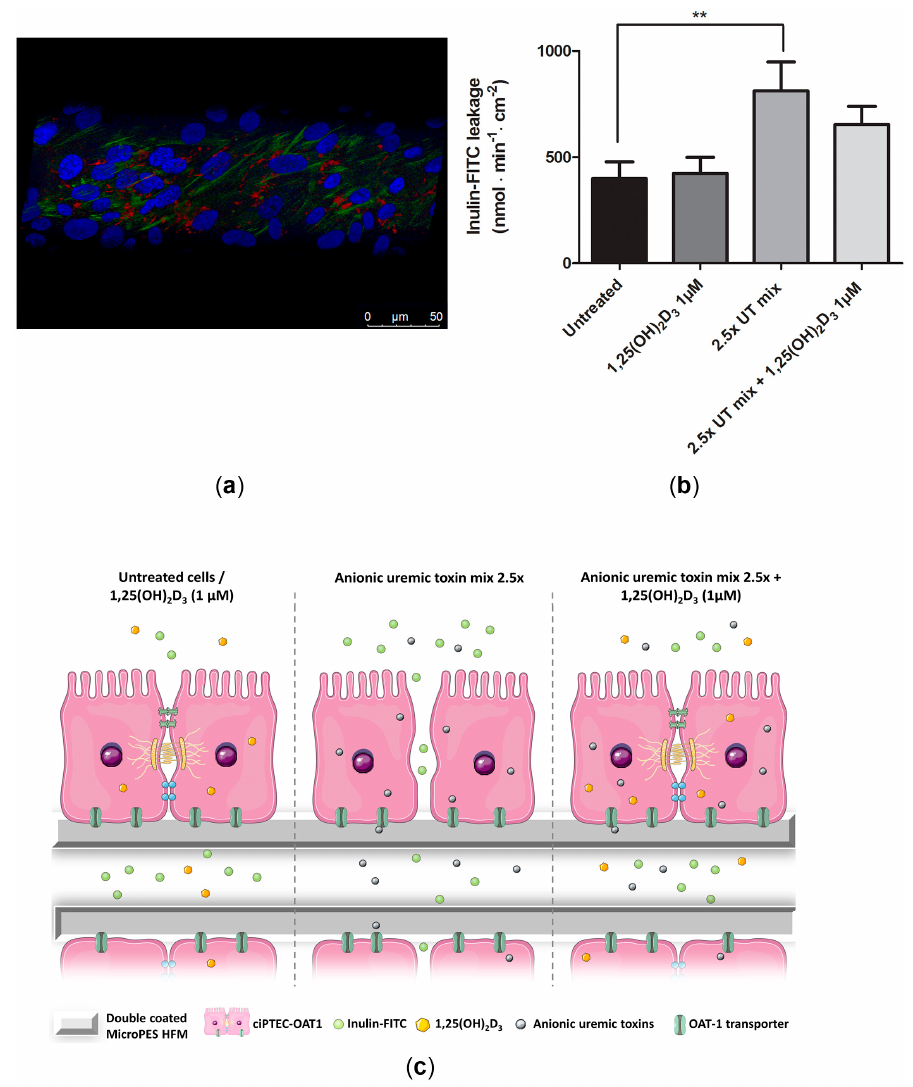
Figure 6. Transepithelial barrier function of ciPTEC-OAT1 cultured on hollow fiber membranes (HFM) in uremic conditions. ( a ) ciPTEC-OAT1 monolayer formation on L -DOPA (2 mg/mL) and collagen IV (25 µ g/mL) coated HFM; ZO-1 expression ( red ), actin filaments ( green ) and nuclear staining with DAPI ( blue ) (25 × magnification); ( b ) transepithelial inulin-FITC diffusion in fibers containing untreated cells, cells exposed to 1,25(OH) 2 D 3 (1 µ M), 2.5 × UT mix and their combination for 24 h.